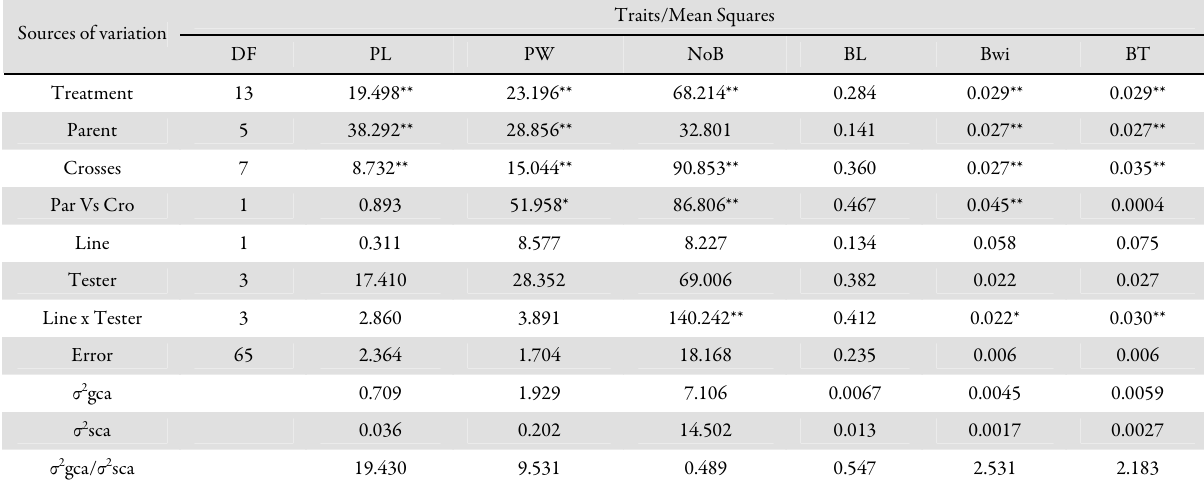
Tab. 3. Analysis of variance summary of the two lines by four testers